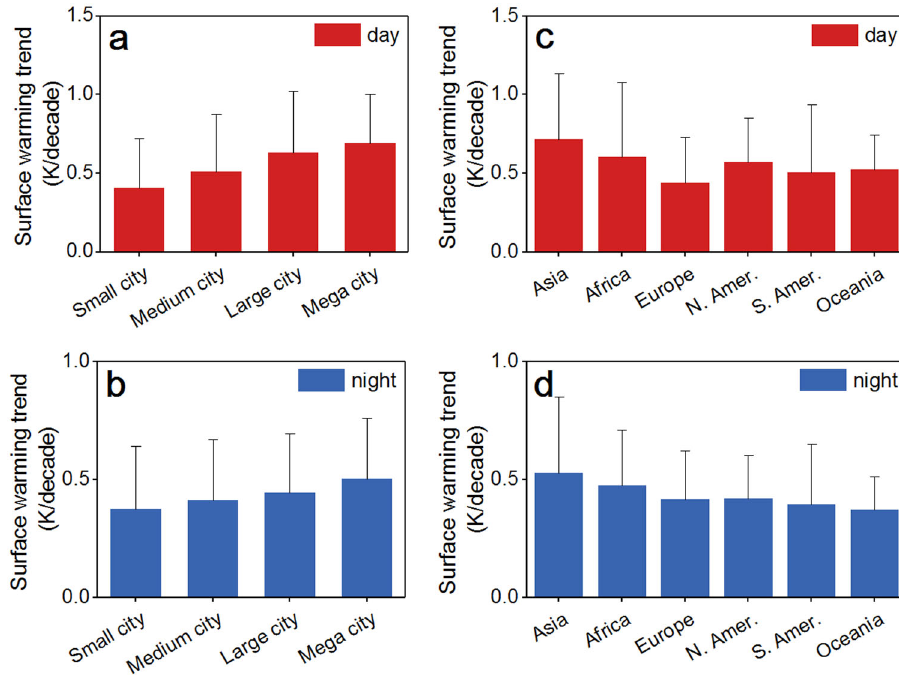
Fig. 2 Surface warming trend at the urban core by city size and continent. Note that the error bars represent 10%~90%